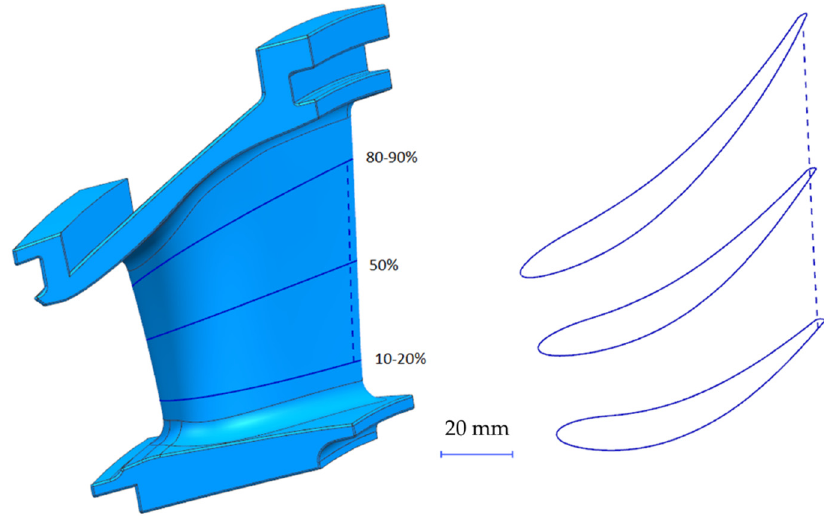
Figure 3. Measuring sections with trend line.